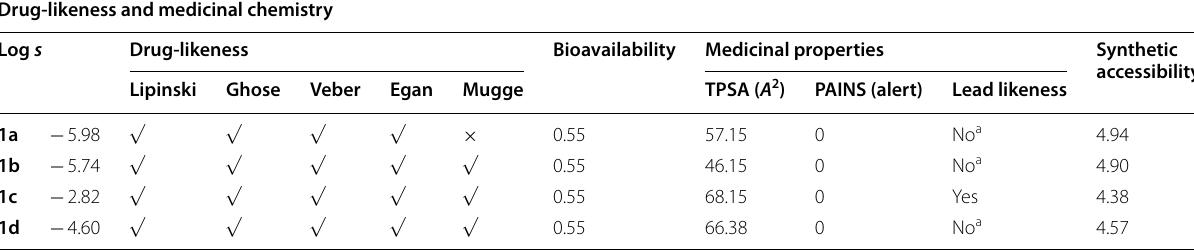
1a, gangetin; 1b, gangetinin; , 1c, desmocarpin; 1d, desmodin; Log s , solubility class; TPSA, topological polar surface area; PAINS, pan-assay interference structure a Molecular weight < 350